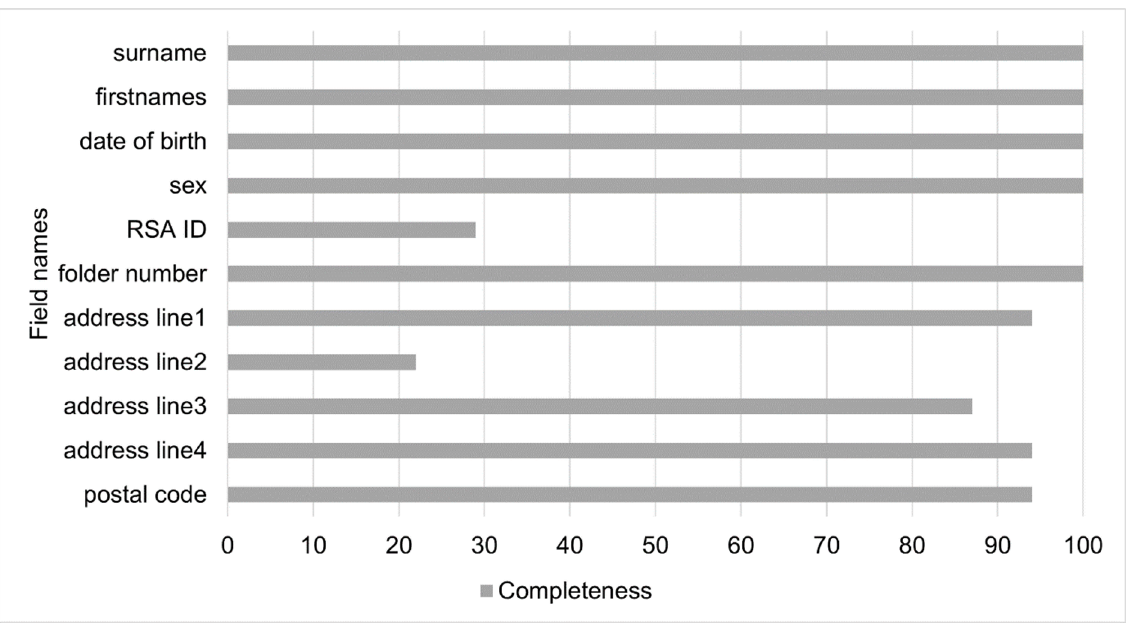
Figure 4: Percent completeness among linkage variables using data from new patients who registered between 2015 and 2020